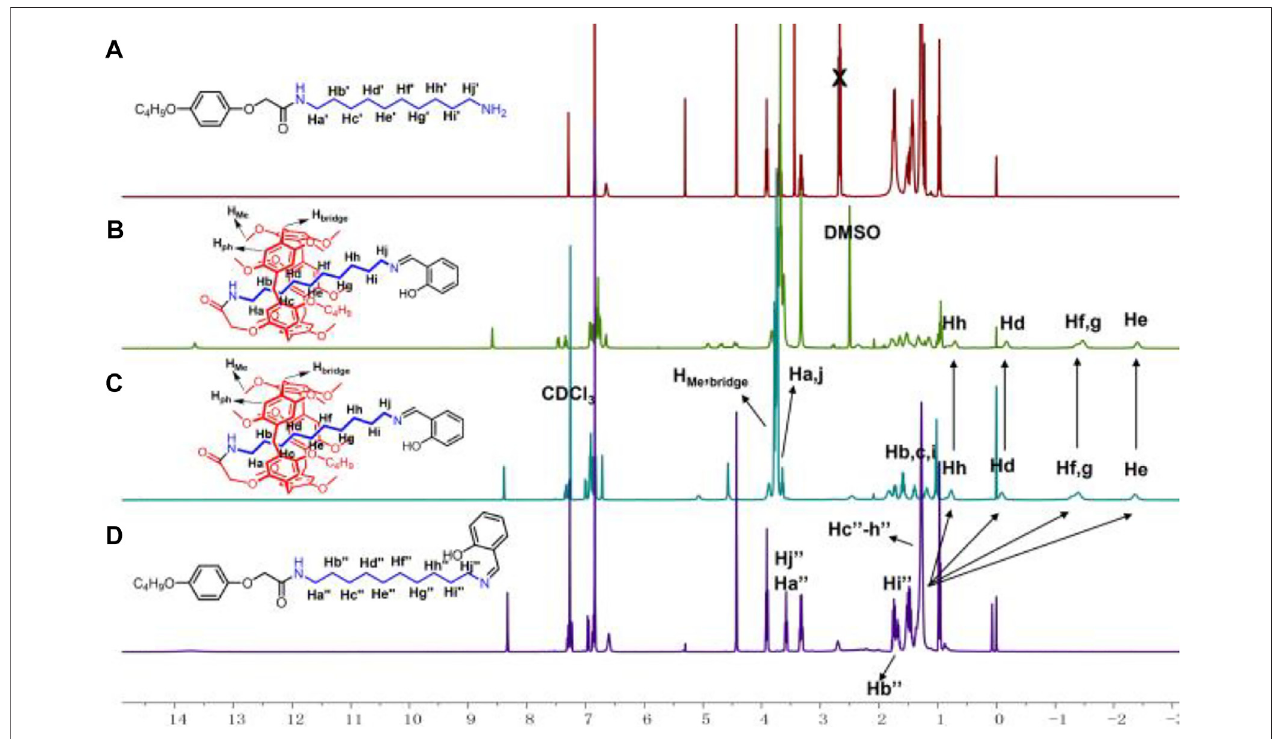
FIGURE 1 | 1 H NMR spectra (400 MHz, 298K) of (A) monomer-1 in CDCl 3 , (B) 6e in DMSO-d 6 , (C) 6e in CDCl 3 , and (D) monomer-2 in CDCl 3 .